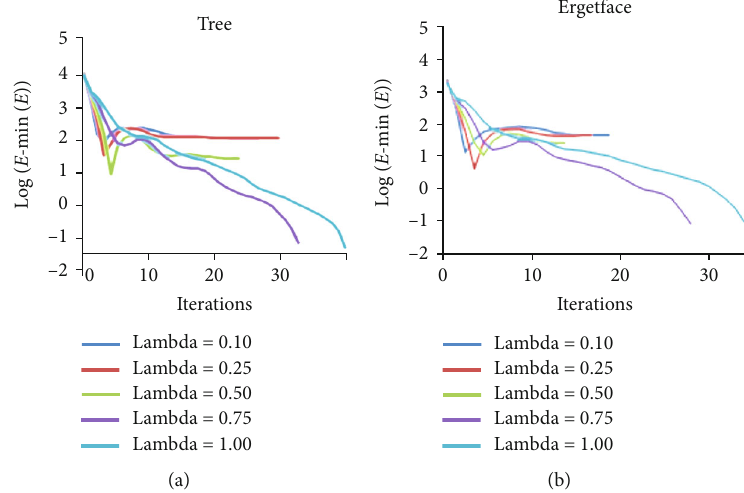
Figure 3: Behaviour of E for di ff erent values of λ with tolerance = 0 : 1 .